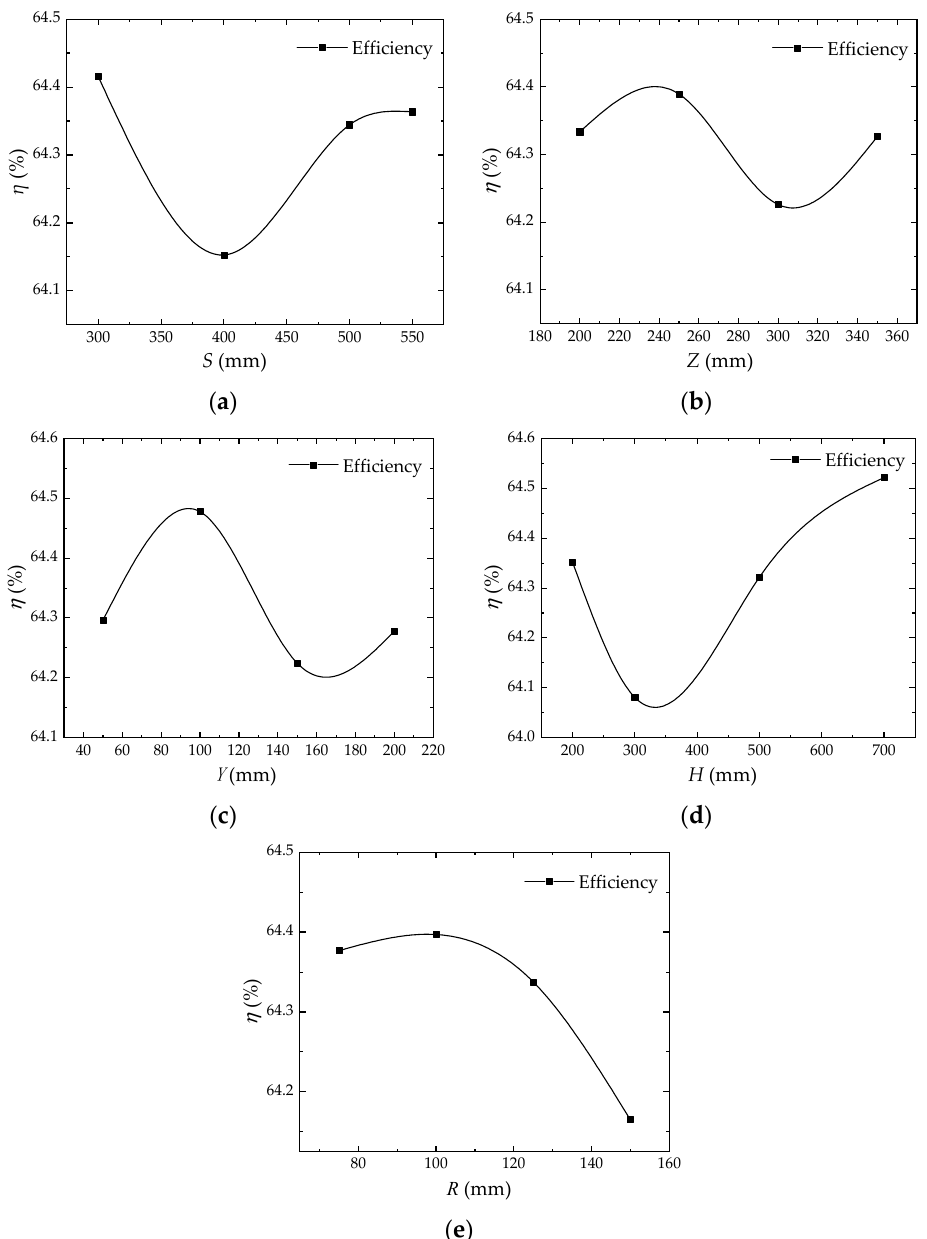
Figure 7. Prefabricated pumping station efficiency and each factor of the relationship curve. ( a ) Pump spacing S . ( b ) Suspended height Z . ( c ) Center spacing Y . ( d ) Inlet height H . ( e ) Inlet radius R